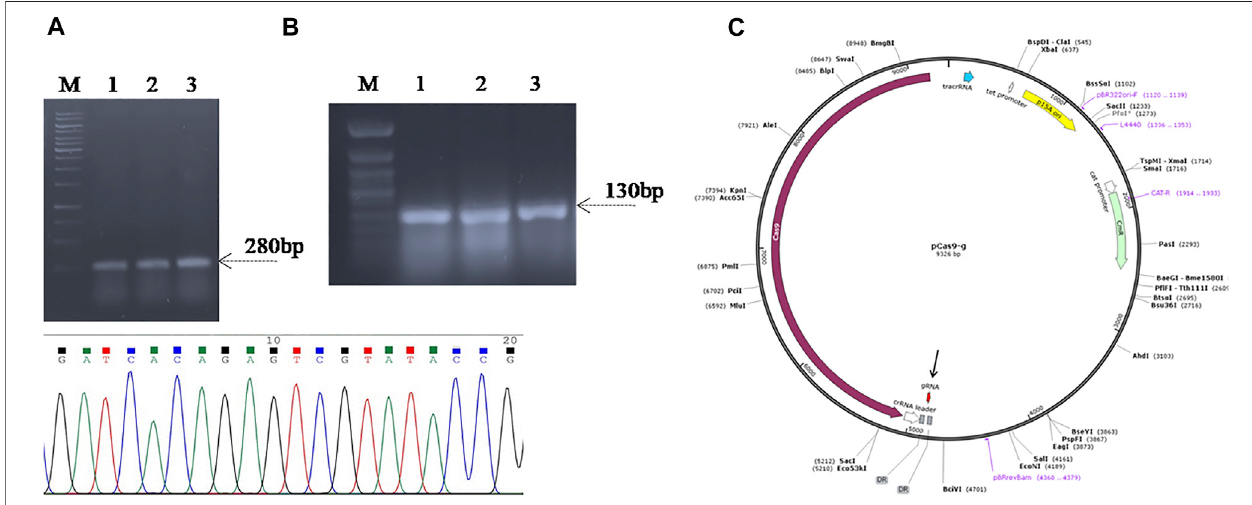
FIGURE2| Con fi rmationofspacerRNA(gRNA)cloningin (A) pCas9 (B) andpCasSAvectorsthroughPCRandSangersequencing.Lanes1 – 3,colonyPCRofthe Top10 cells carrying recombinant pCas9-g showed ampli fi cation of a 180 bp fragment suggest the cloning of gRNA in pCas9. Lanes 4 – 6, colony PCR of the cells carryingtherecombinantpCasSA-gplasmidampli fi ed130 bpfragmentsuggestthecloningofgRNAinpCasSA,whichisfurthercon fi rmedthroughSangersequencing shown in the chromatogram. (C) Plasmid map of recombinant pCas9-g carrying spacer RNA targeting the SpvB gene. The gRNA (colored red) is denoted with an arrow. Lane M, Gene Ruler 1 kb DNA ladder (SM0311), Lane M*, Gene Ruler 50 bp DNA ladder (SM0371) was used as the DNA ladder.